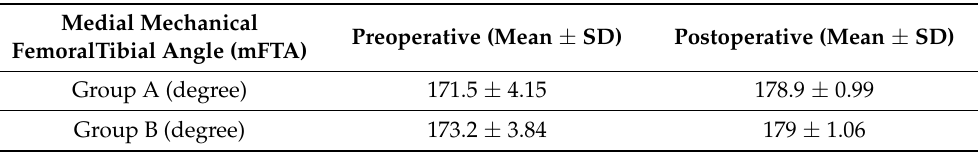
Table 2. Preoperative and postoperative lower limb mechanical alignment for each group of studied patients.